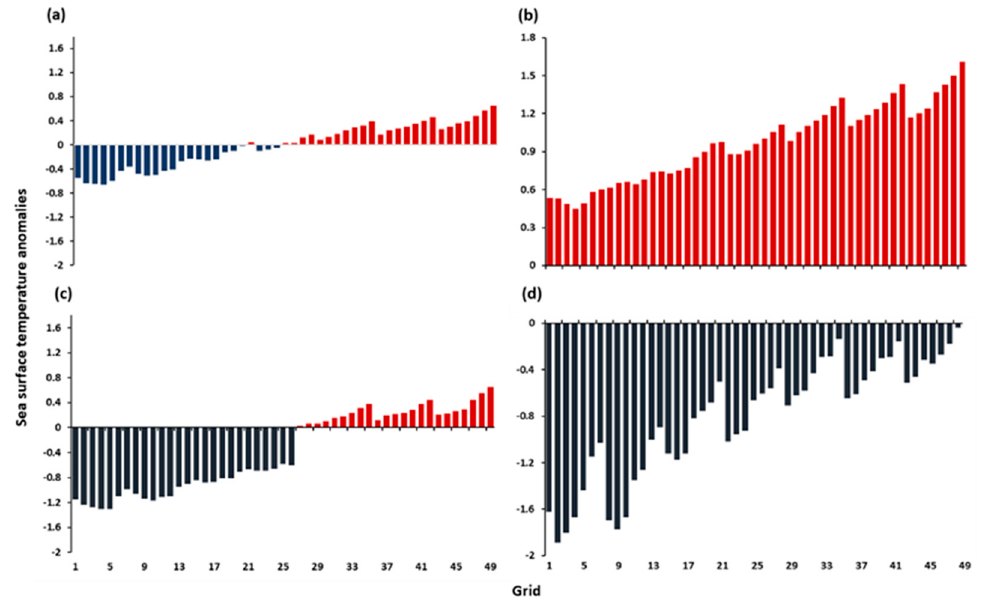
Figure 6. Time series of SSTAs for 49 grids ( a ) during 2002–2015, ( b ) for category A, ( c ) for category B, and ( d ) for category C. Red columns represent positive SSTAs and blue columns represent negative SSTAs. The lower grid cell numbers occur in the northern part of the PHI, with higher numbers towards the southern part of the study area.